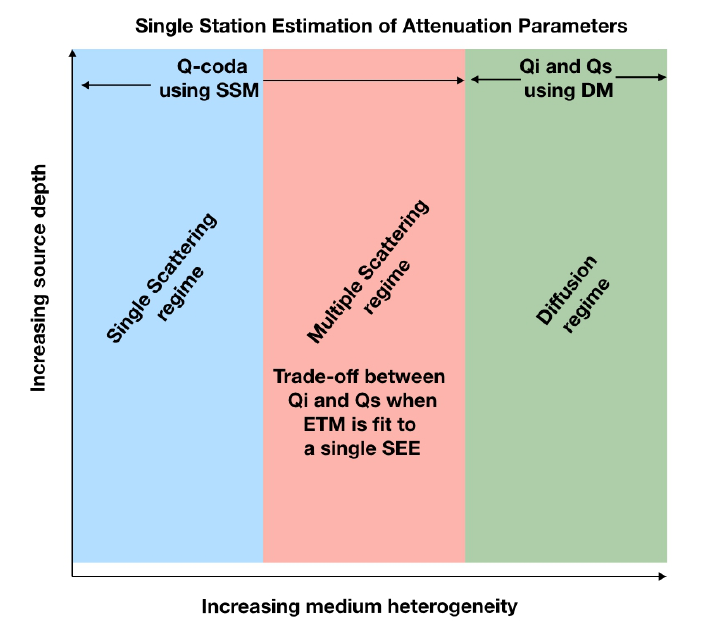
Figure 9. Qualitative scheme to show how SEE should be fitted. SEE measured from single seismograms recorded in media with increasing heterogeneity and shallow source depths are candidate for being fitted to